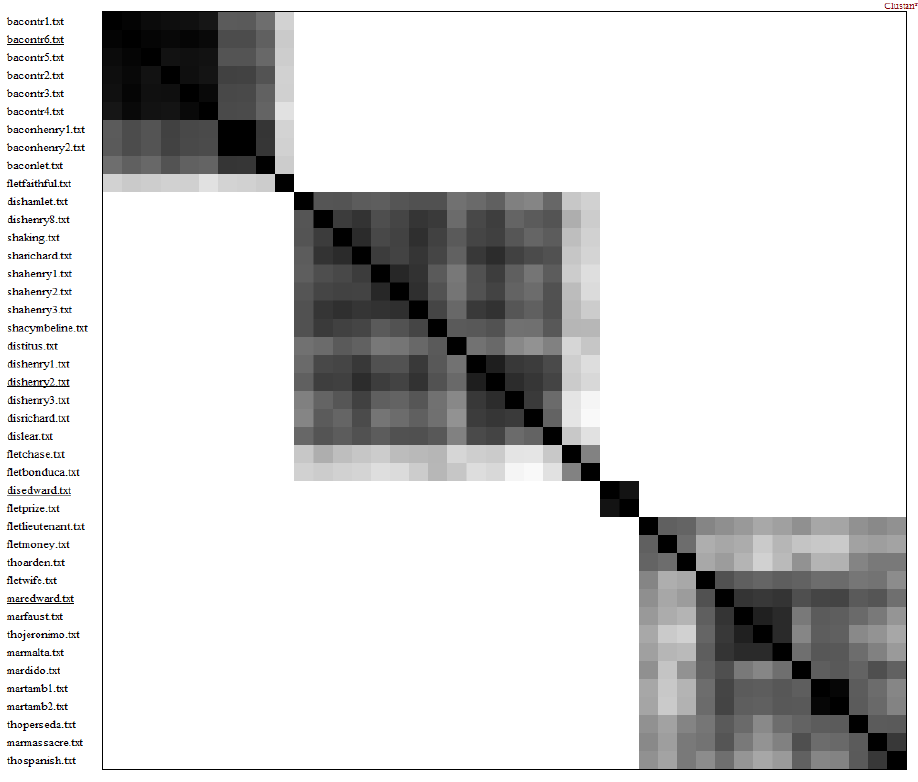
Figure 20. An assessment of clustering tendency test for D trigram